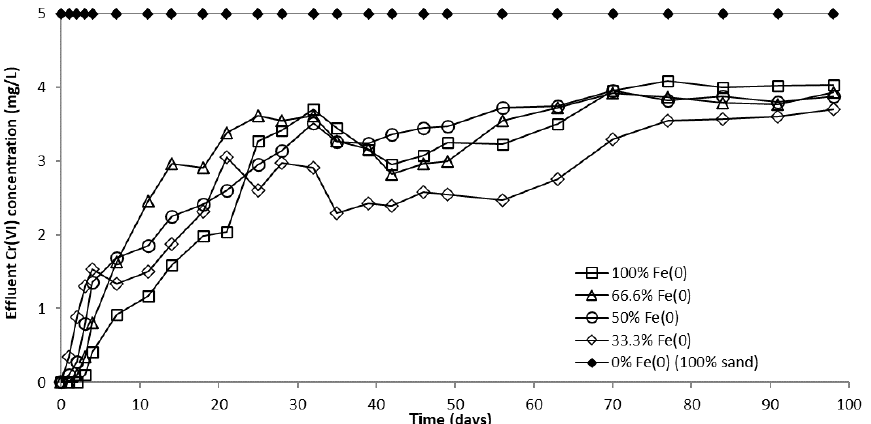
Figure 8. Cr VI concentration in column effluent vs. time for columns having fixed Fe 0 volume and variable total reactive zone volume V 2 at initial pH 6.5 .